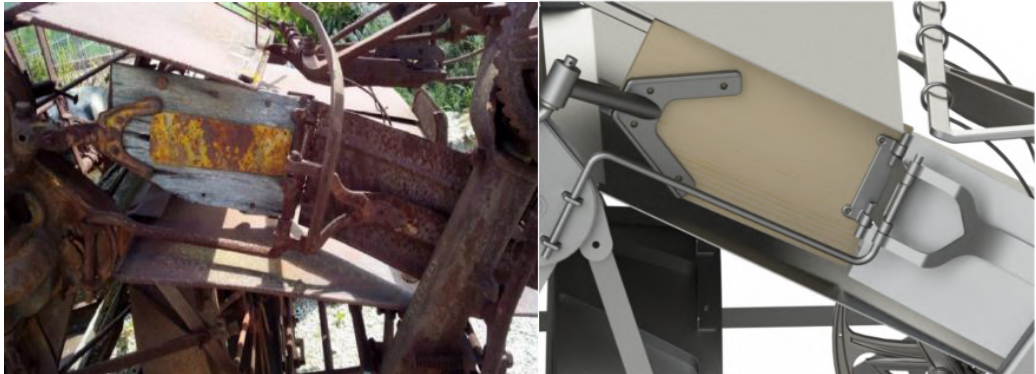
Figure 19. Sheaf grouping system ( left ) and 3D CAD model ( right ).